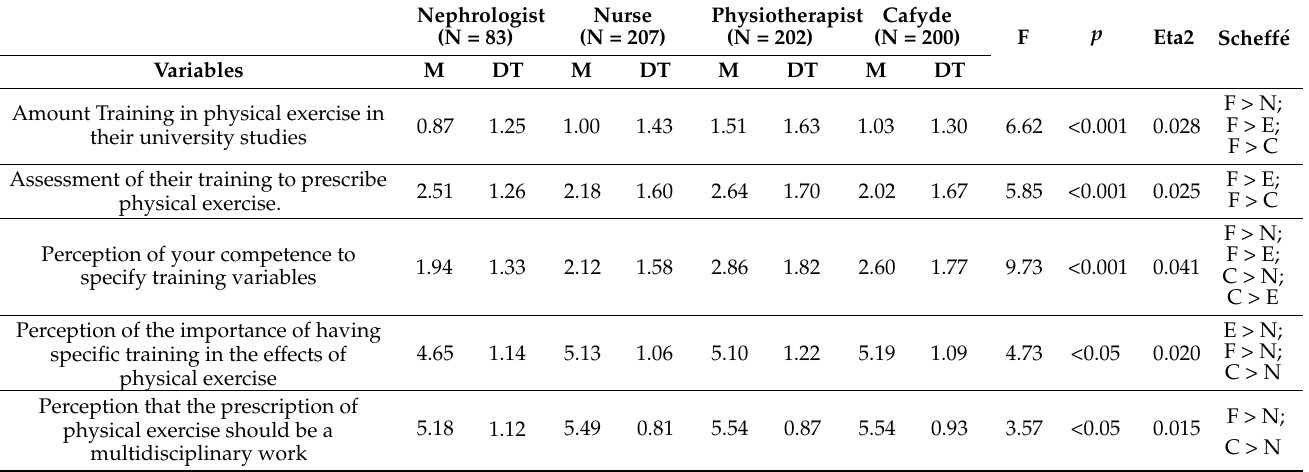
Table 3. Results of the Analysis of Variance and the subsequent Schefe é test of the variables on the perception of the professionals with respect to their training. (N = Nephrologist; E = Nurse; F = Physiotherapist and C =